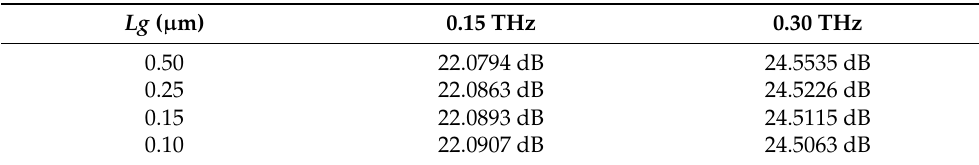
Table 1. Maximum value of the normalized electric field component along x axis in dB for frequencies 0.15 and 0.30 THz.